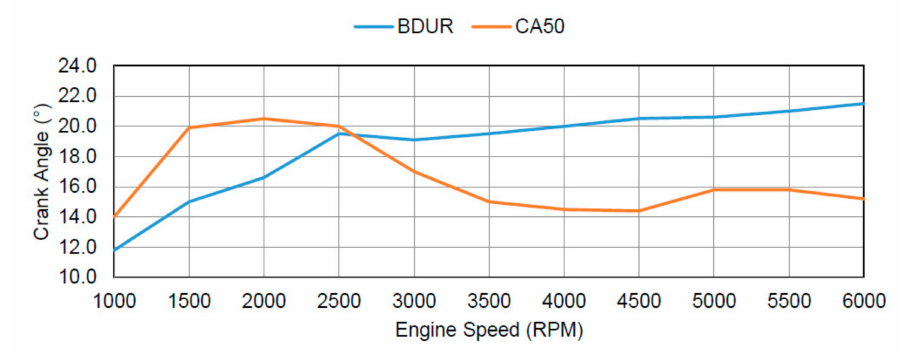
Figure 3. SI Wiebe combustion model parameters.